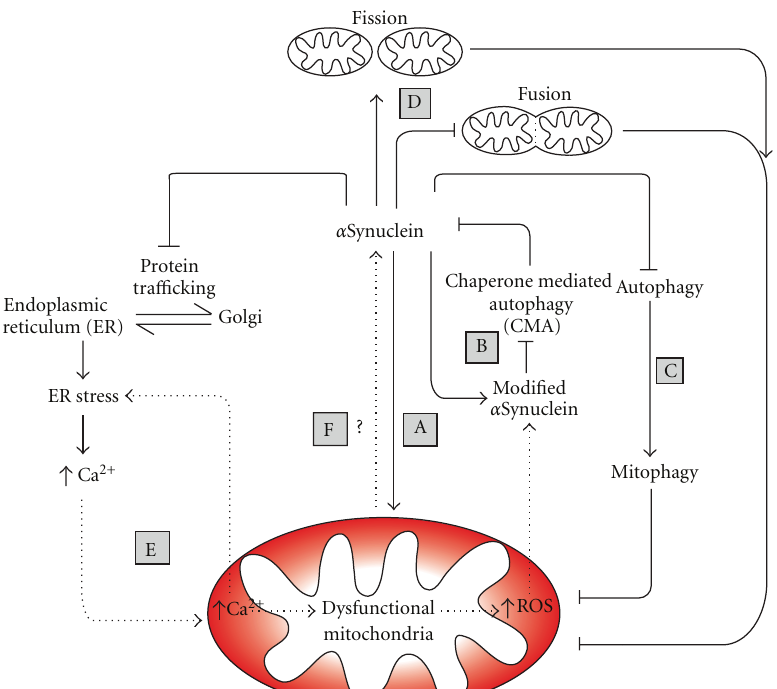
Figure 1: The interrelationship between mitochondrial dysfunction and α Synuclein toxicity. α Synuclein toxicity, directly or indirectly, impairs mitochondrial function (A). A prominent result of this dysfunction is the production of reactive oxygen species (ROS) which can be counteracted by the cellular ROS bu ff ering systems. However prolonged mitochondrial stress, exacerbated by α Synuclein, has the potential to deplete this bu ff ering capacity, and the resulting increase of cellular ROS has multiple damaging e ff ects such as the modification of α Synuclein (B). Modified α Synuclein can inhibit chaperone-mediated autophagy (CMA), increasing the proteins toxicity by its ine ffi cient clearance. α Synuclein toxicity is dose dependant, and excessive amounts of α Synuclein have the potential to block autophagy pathways (i.e., macroautophagy and mitophagy). This results in an accumulation of dysfunctional mitochondria due to ine ffi cient clearance (C). α Synuclein toxicity can also increase mitochondrial fission and inhibit mitochondrial fusion (D). Both the increase in mitochondrial fragmentation and the inability of mitochondria to rejoin the mitochondrial network result in an increase in dysfunctional, depolarised mitochondria. α Synuclein toxicity also blocks endoplasmic reticulum (ER) to Golgi tra ffi cking resulting in ER stress. When under constant and prolonged stress, the ER releases Ca 2+ into the cytosol. Due to mitochondrial-ER contact sites, mitochondria readily bu ff er cytosolic Ca 2+ ; however, excess Ca 2+ in the mitochondria causes mitochondrial stress (E). Dysfunctional mitochondria in turn release Ca 2+ into the cytosol causing further ER stress. Mitochondrial dysfunction may exacerbate α Synuclein toxicity (F), with both acting synergistically to enhance each other in a self-amplifying cycle over prolonged periods of time, resulting in multiple downstream e ff ects, including cell death as seen in